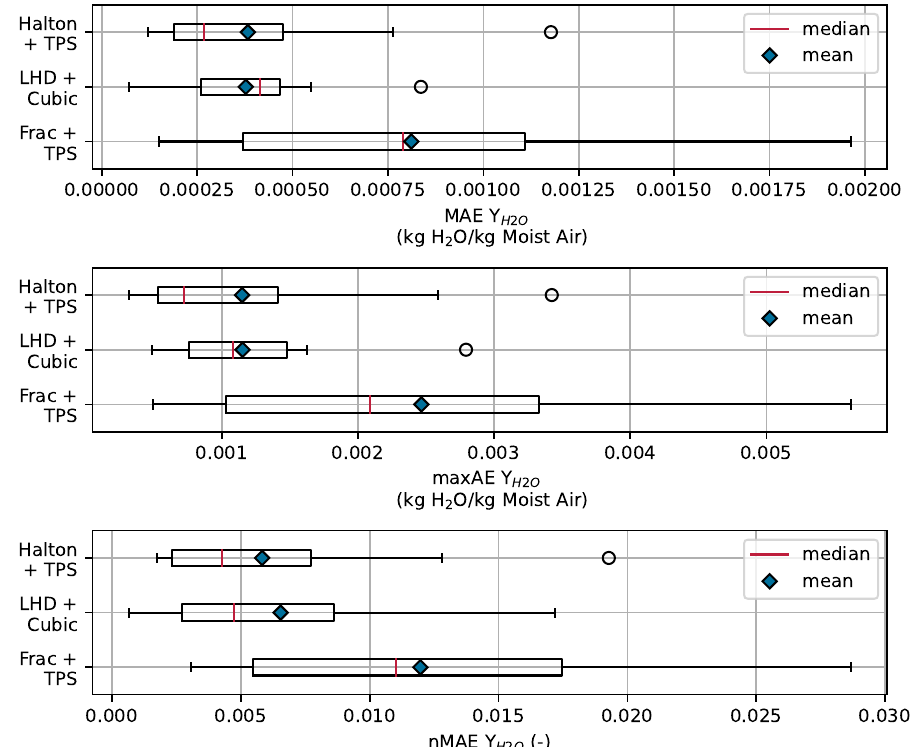
Figure 8. Comparison of the surrogate models in terms of the defined metrics. The metrics are evaluated for the water mass